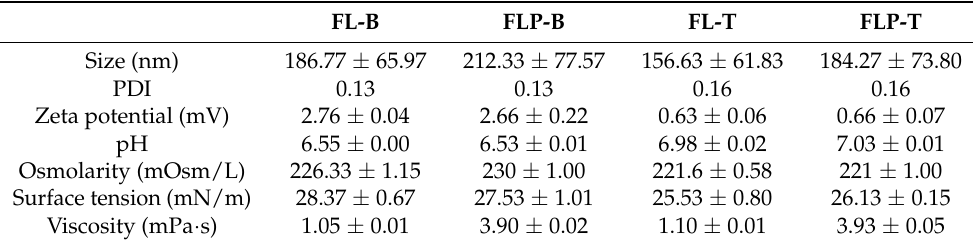
FL: DOPC 7.5 mg/mL, DMPC 2.5 mg/mL, vitamin E 0.1 mg/mL, Ubiquinol 0.025 mg/mL, Taurine 0.5%, Ribitol 0.5%; FLP: DOPC 7.5 mg/mL, DMPC 2.5 mg/mL, vitamin E 0.1 mg/mL Ubiquinol 0.025 mg/mL, Taurine 0.5%, Ribitol 0.5%, HPMC